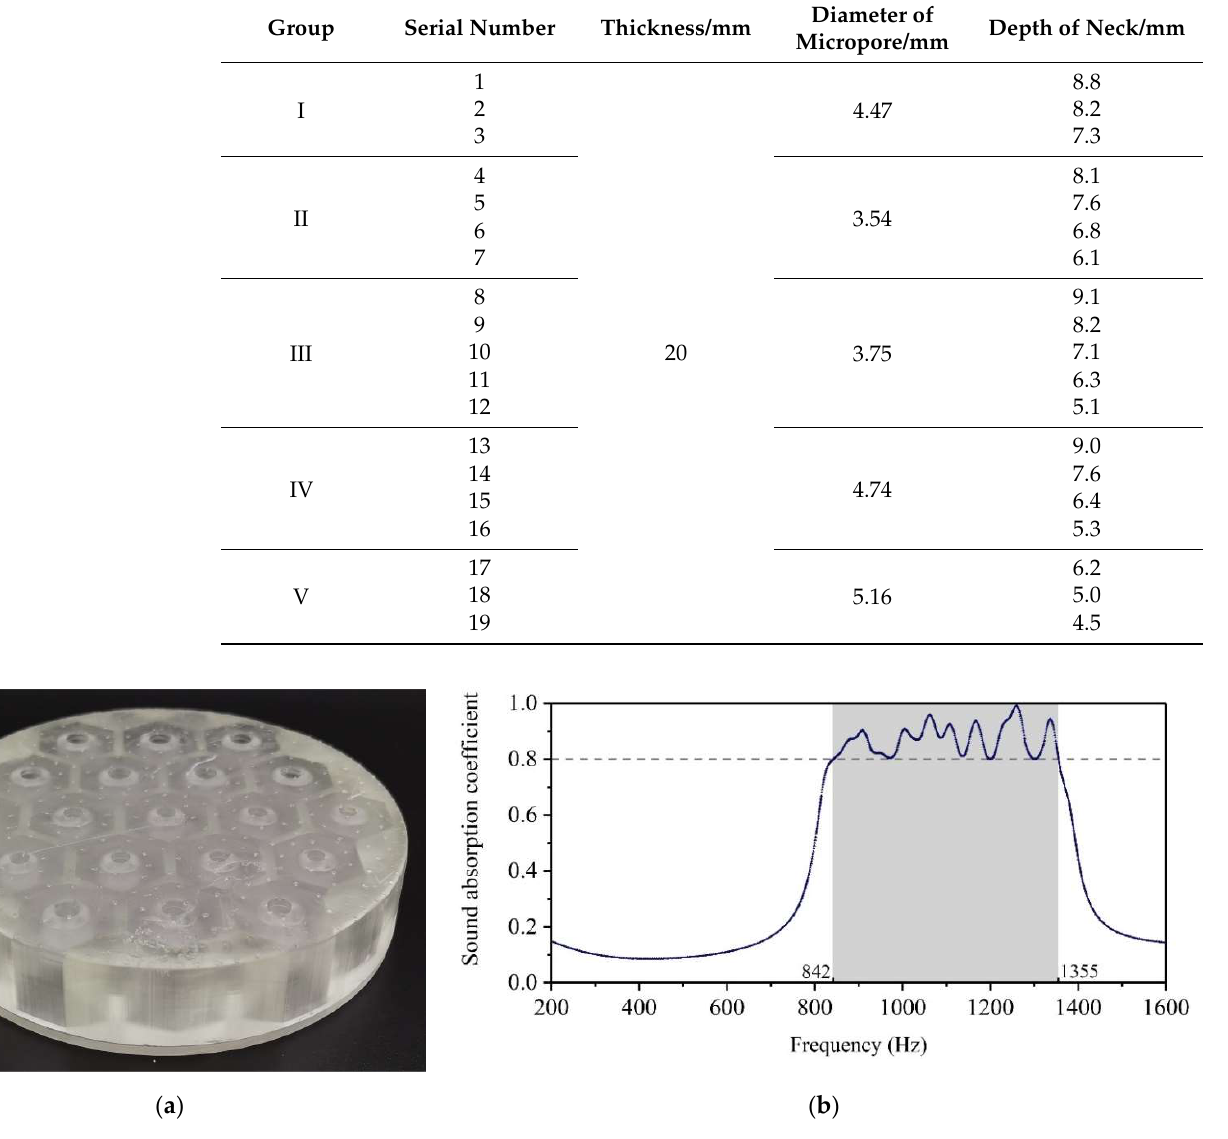
Table 3. The optimized geometric parameters for design requirements of Condition-1.